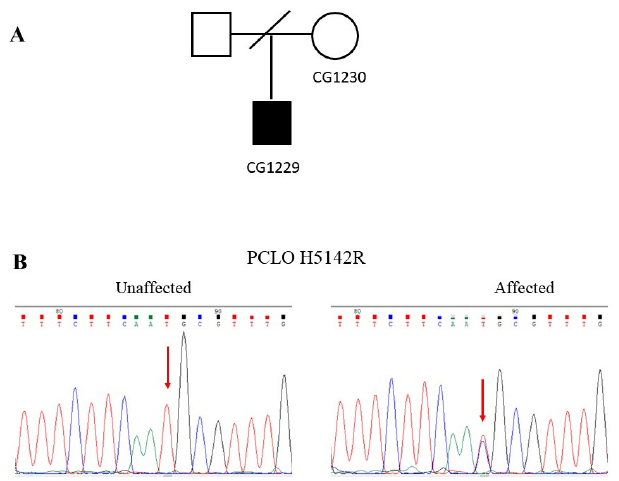
Figure 3. Family with the H5142R mutation of the PCLO gene. ( A ) A pedigree of family 3 with a patient diagnosed with paranoid schizophrenia. ( B ) Chromatograms show the wild-type T homozy- gote at the nucleotide position 82387895 of the unaffected mother’s PCLO gene. At the same time, the patient was a heterozygote of the T-to-C mutation of the PCLO gene. Table 2. Location, frequency, and in-silico functional prediction of the three mutations identified in this study. Gene Name and dbSNP